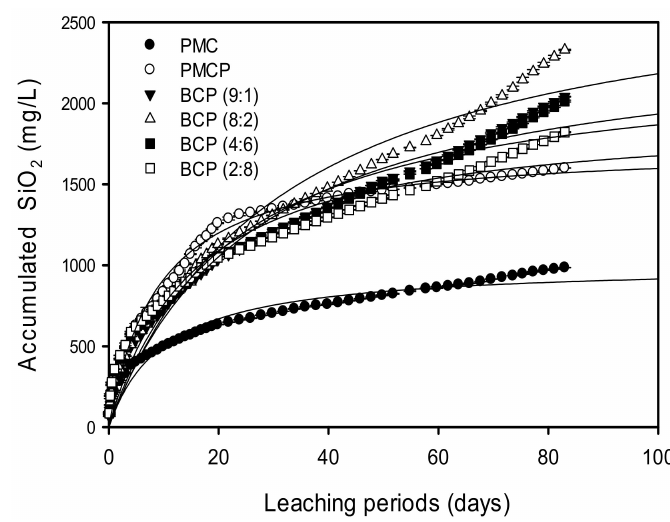
Figure 5. Effects of accumulated SiO 2 concentrations in the releasing water from biochar pellet blended with various ratios of pig manure compost during leaching periods. Table 5. Estimation model for accumulated SiO 2 releasing amount from different types of biochar pellets.